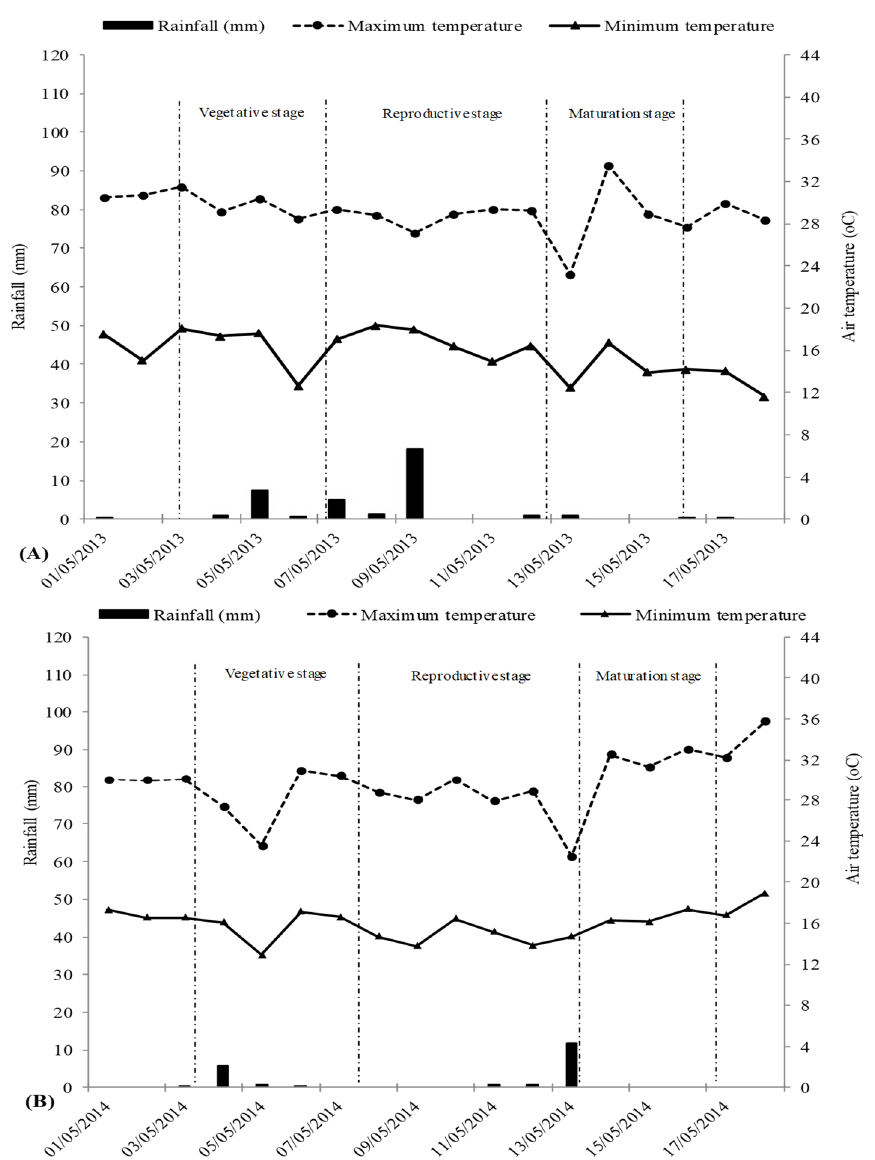
Figure 1. Rainfall (mm), maximum and minimum temperatures (°C) during winter bean cultivation, Selvíria, MS- Brazil in 2013 ( A ) and 2014 ( B ) harvests.